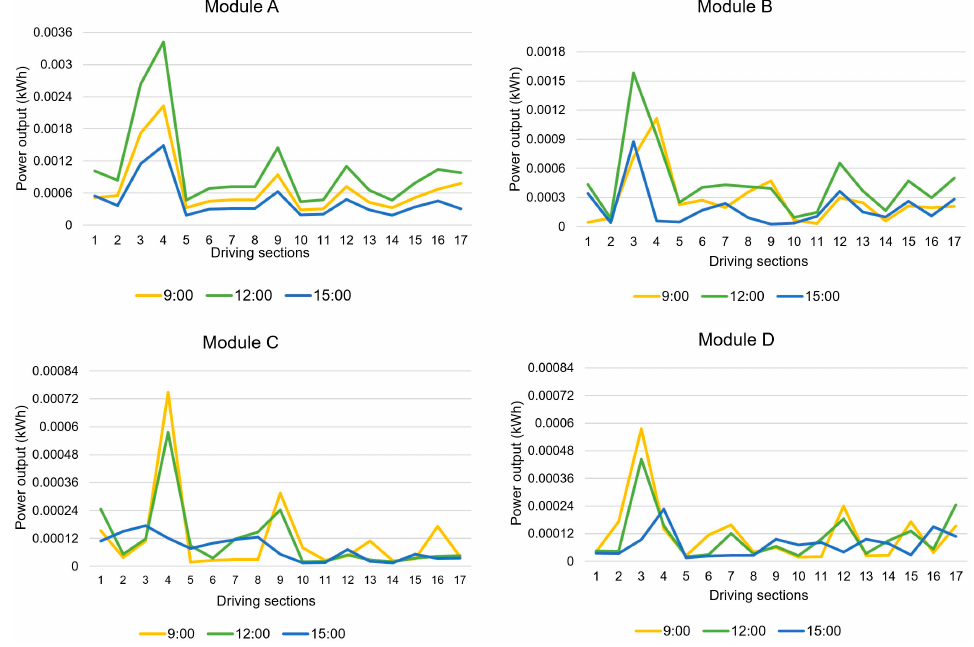
Figure 6. Graphs of the PV potential of the driving sections over time for each module.